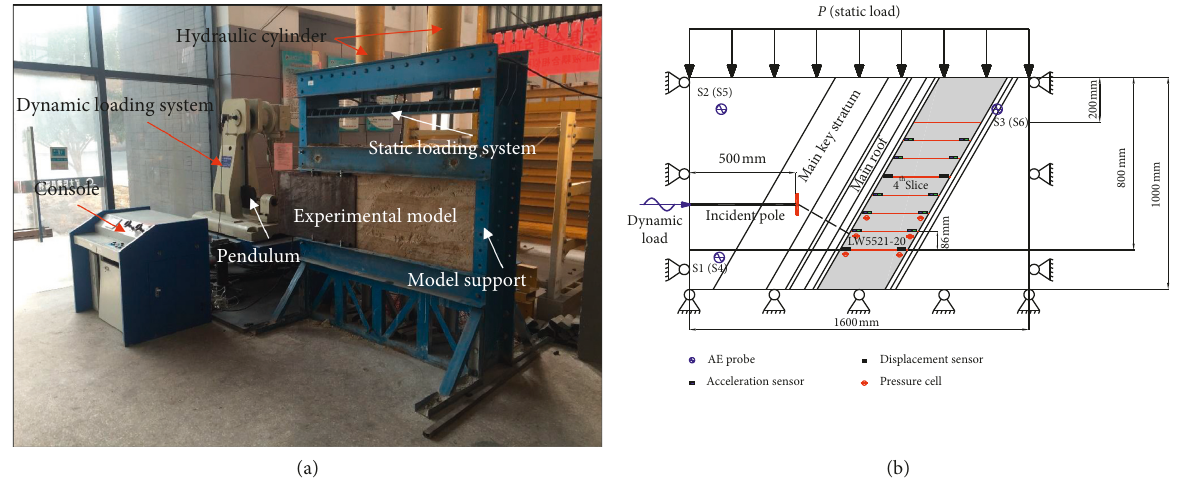
Figure 4: Similarity simulation test bench under superimposed dynamic and static load. (a) Physical picture of the test apparatus. (b) Design of the test model.